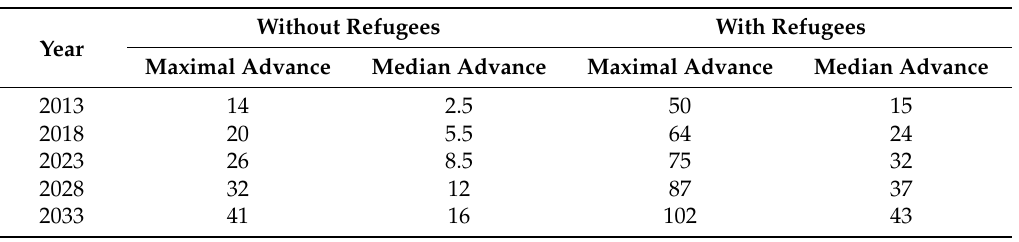
Table 5. Impact of migration patterns on the maximal and median advancement on land of the seawater/freshwater interface.